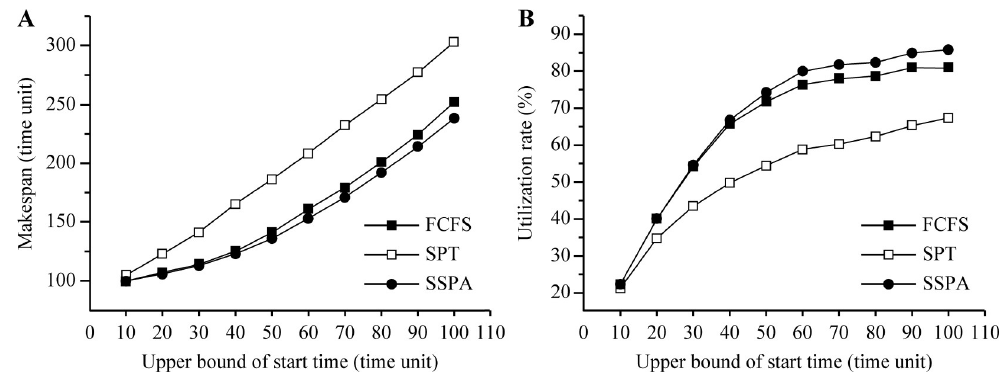
Fig 7. Results for variable upper bound of start time. (a) Makespan and (b) utilization rate.